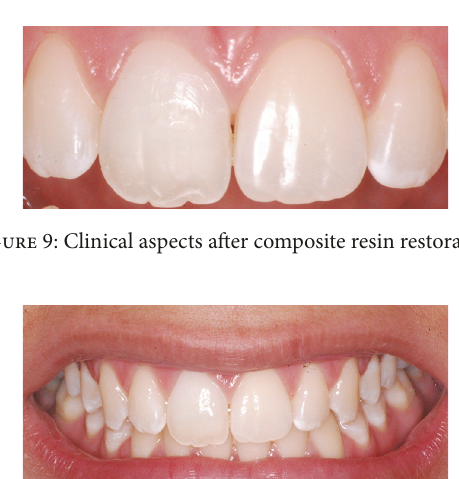
Figure 7: Radiograph after endodontic treatment.